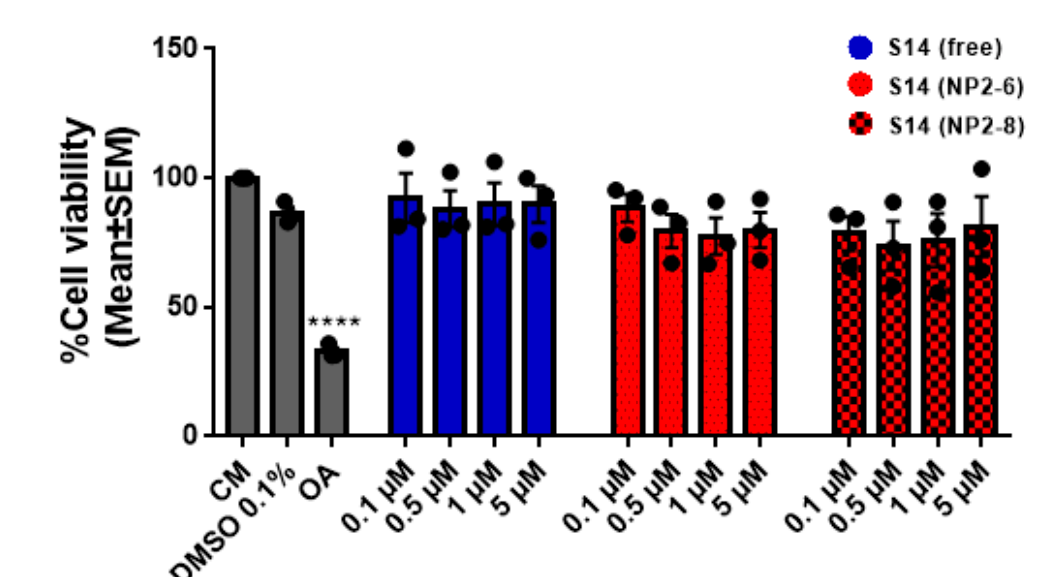
Figure 7. Cell viability of SH-SY5Y treated with increasing doses of free S14 and S14-loaded NPs for 24 h. Complete Media (CM) was used as vehicle for NPs, DMSO was used as vehicle for free S14 and Okadaic acid (OA) was used as internal control. Data represent the mean ± SEM of 3 different experiments. (**** p < 0.0001 significantly different from CM).